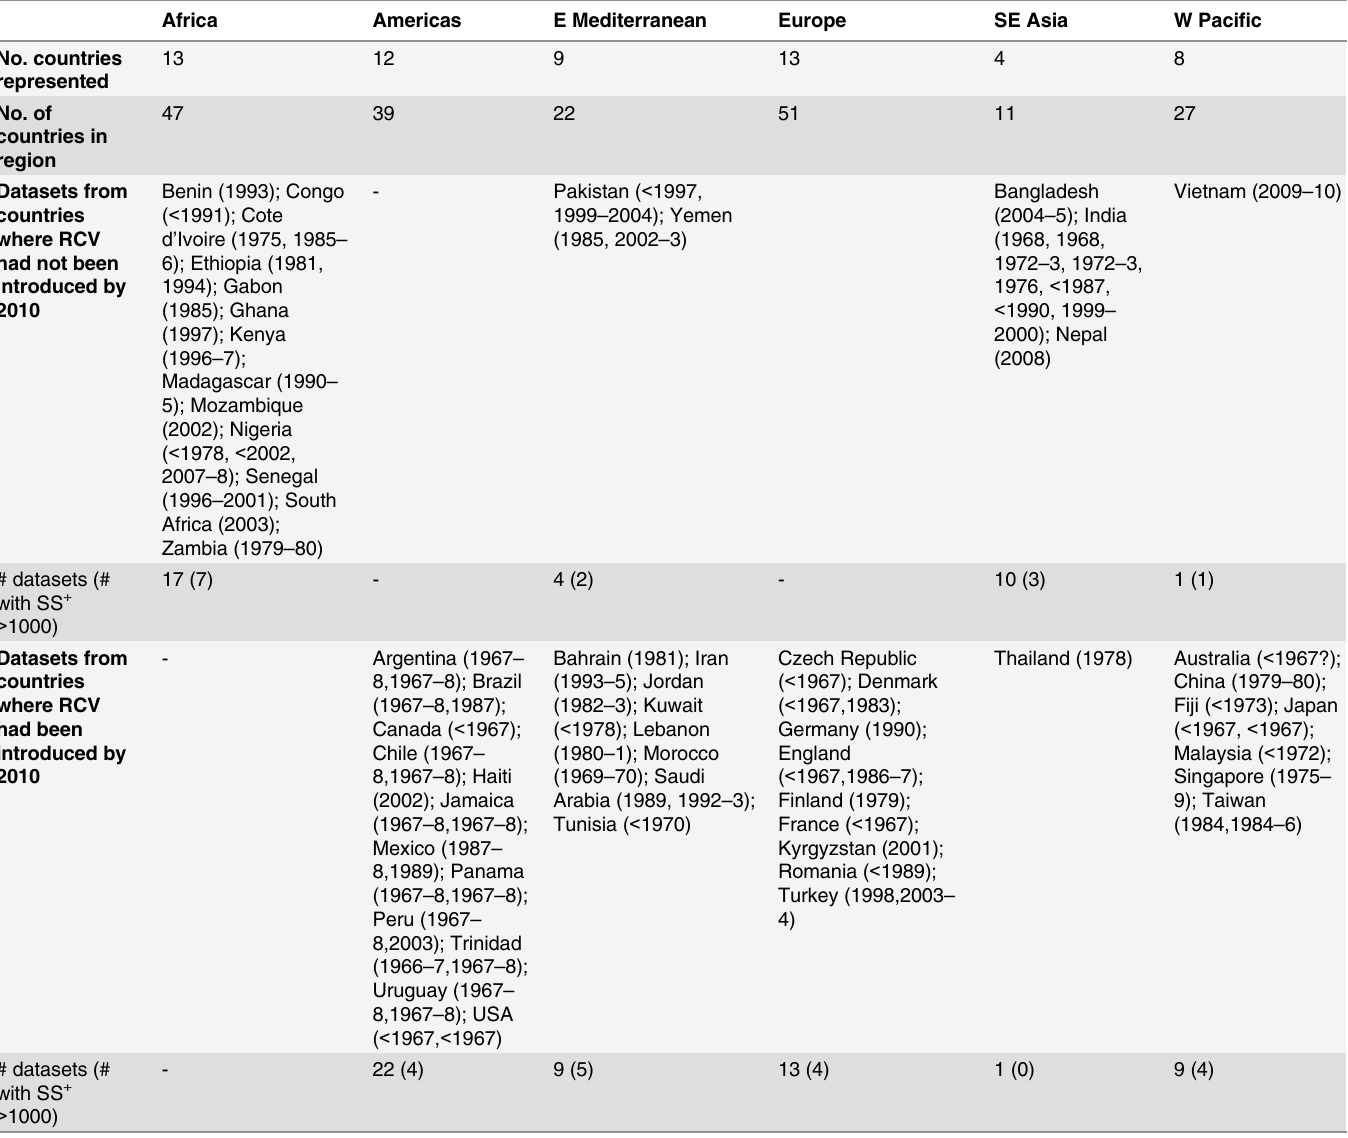
Table 3. Summary of the serological datasets collected before the introduction of vaccination which were used to estimate the global burden of